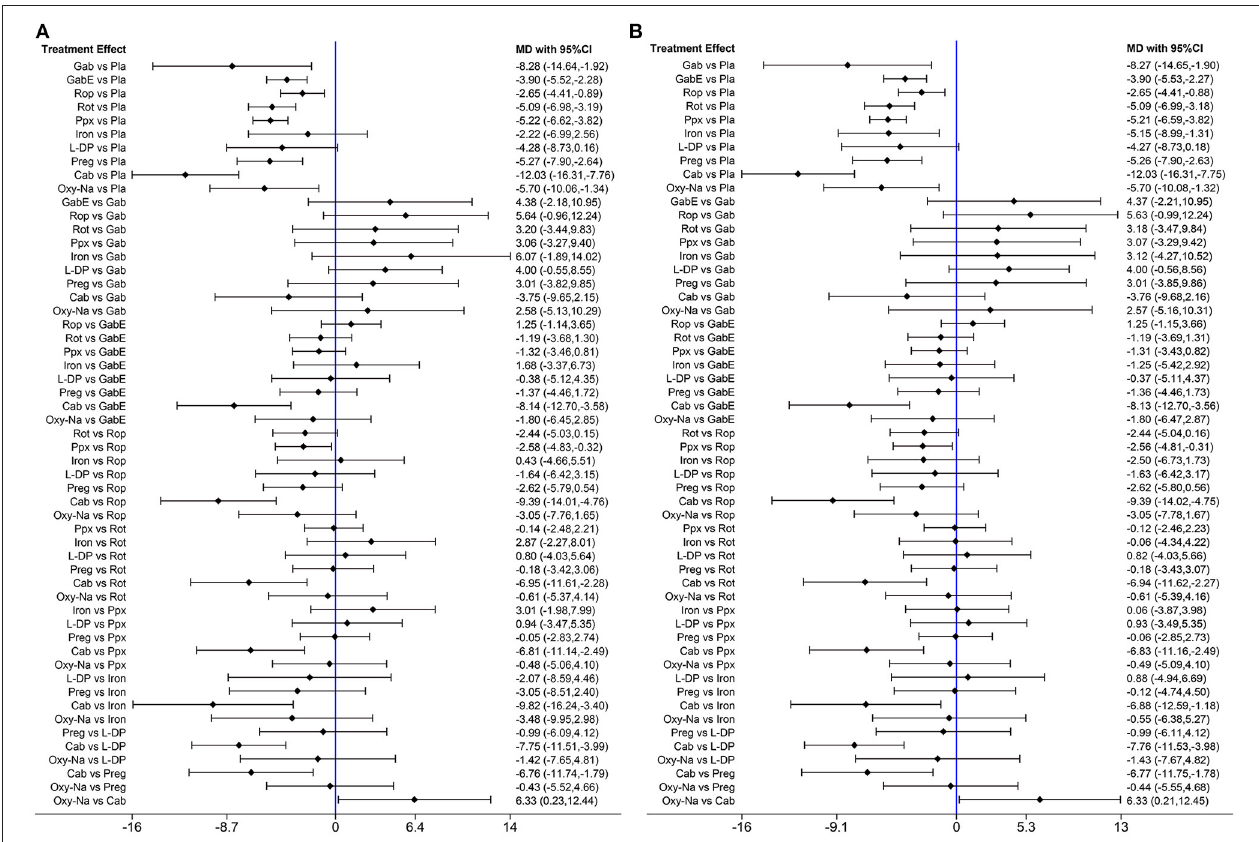
FIGURE 6 | (A) The network analysis result after removing studies with uncertain serum ferritin level or low serum ferritin level (studies iron supplement for RLS with serum ferritin level upper than 45 ug/l included). (B) The network analysis result of different drugs in treatment of RLS patients with low serum ferritin level. (Gab, Gabapentin; GabE, Gabapentin enacarbil; L-DP, Levodopa; Rot, Rotigotine; Ppx, Pramipexole; Cab, Cabergoline; Rop, Ropinirole; Preg, Pregabalin; Oxy-Na, Oxycodone-naloxone; Pla,